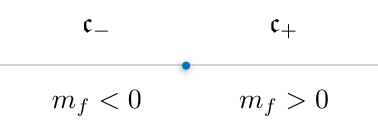
Figure 2 . Chambers c